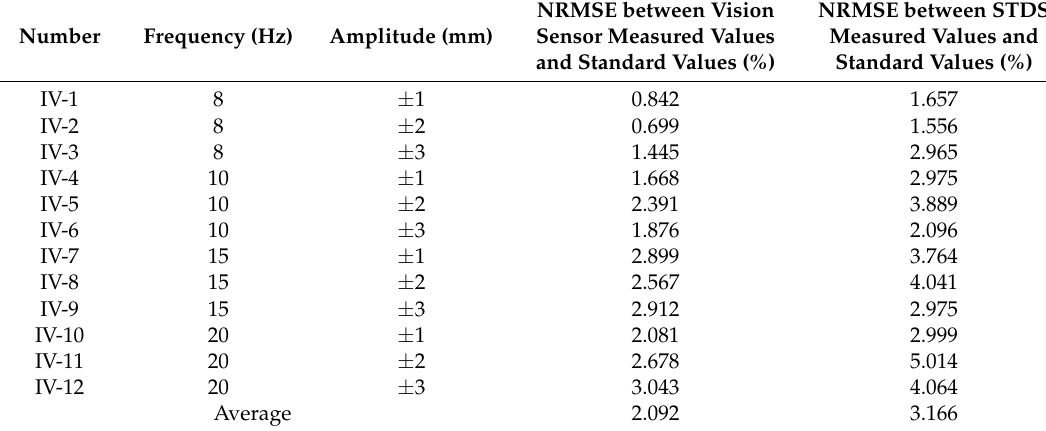
Table 13. NEMSE errors analysis of shaking table experimental results.